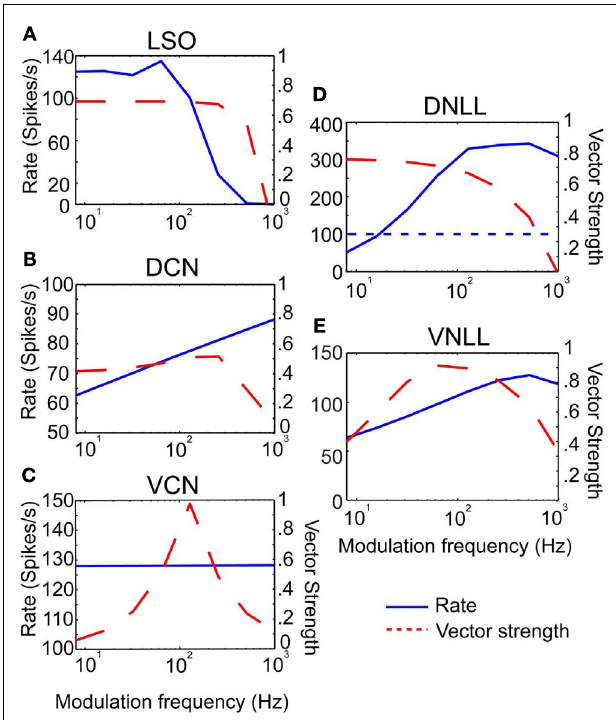
FIGURE 2 | Excitatory and inhibitory model input characteristics. (A–C) Rate in spikes/s (blue) and vector strength (red) curves characterizing inputs from LSO, DCN, andVCN, respectively. Rate and vector strength are marked on opposing Y -axes. Modulation frequency is marked along the X -axis in Hz. (D–E) Rate and vector strength curves characterizing inhibitory inputs from DNLL andVNLL. DNLL inputs either had all-pass or high-pass rate characteristics, as shown. Axes similar to (A)